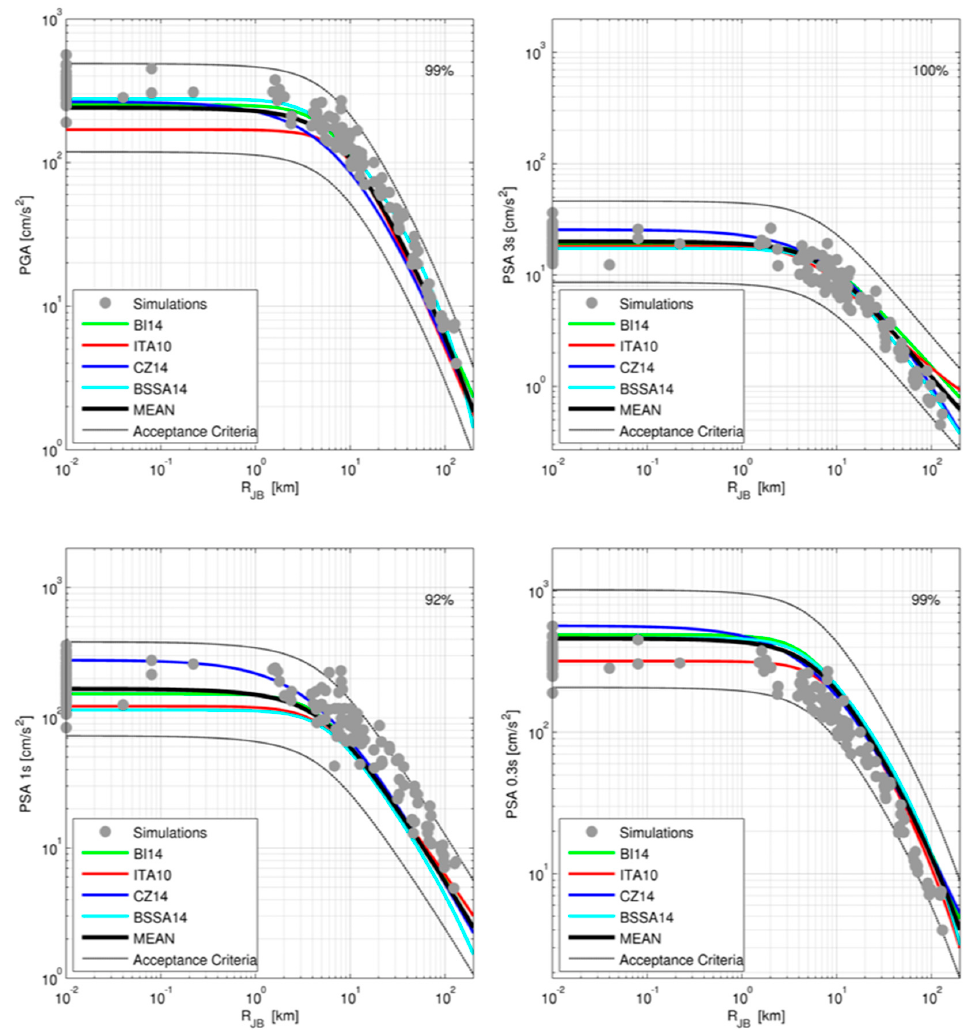
Figure 9. Examples of the validation exercise comparing peak ground acceleration (PGA), pseudospectral acceleration (PSA) at 0.3, 1.0, and 3 s for a M6.0 scenario event with the ground- motion prediction equations. The simulation parameters are: Mw = 6; reverse fault, dip = 45 degrees; depth of the top = 10 km; RV = 2.8 km/s; stress parameter = 150 bars. The GMPEs are BSSA14 [52], CZ14 [51], BI14 [53], and ITA10 [41]. CZ14 was calibrated for rupture distances, and it is plotted against Joyner-Boore distance, considering a scale factor 1:10 for R JB < 20 km. Black line, average of the median prediction from the four GMPEs; dotted gray line, confidence interval calculated considering the upper and lower bounds of the GMPE predictions for the four models; grey circles, single combination of scenario parameters. The percentages of the simulated intensity measures that follow within the confidence interval are also reported.